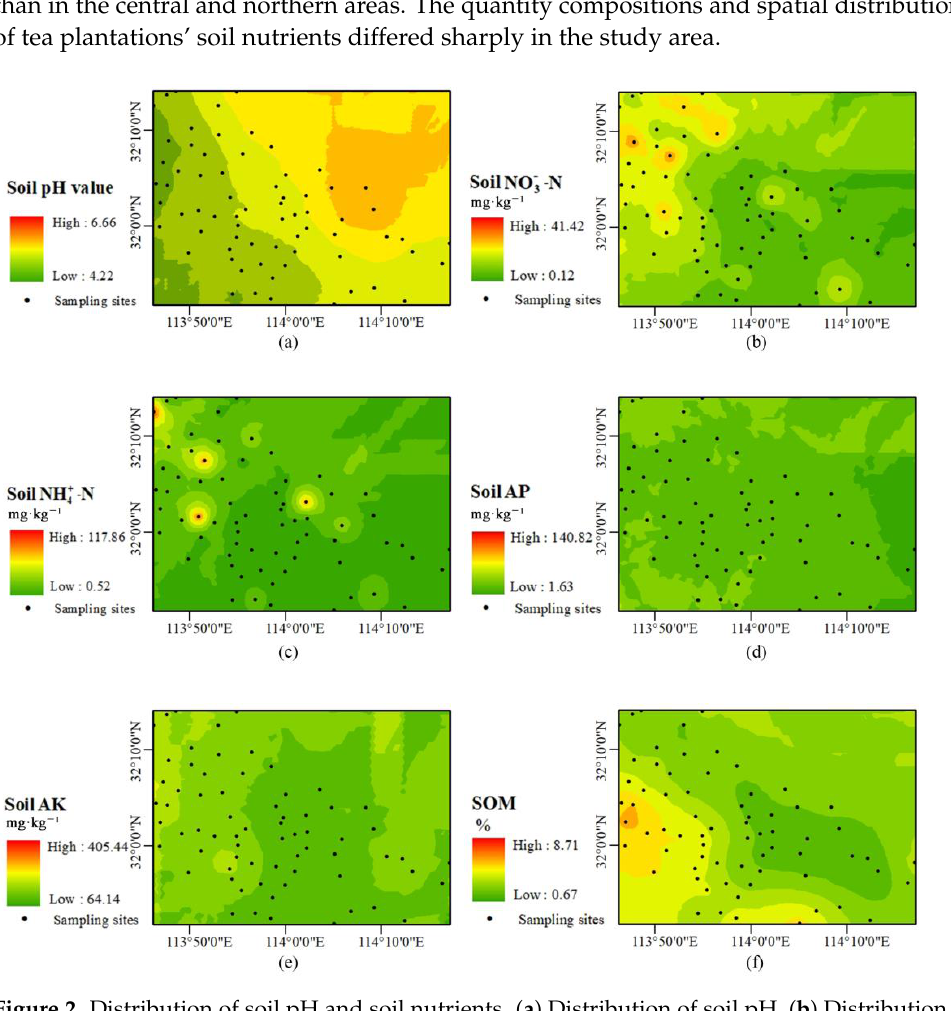
Table 1. Descriptive statistics of the soil pH and concentrations of soil nutrients.